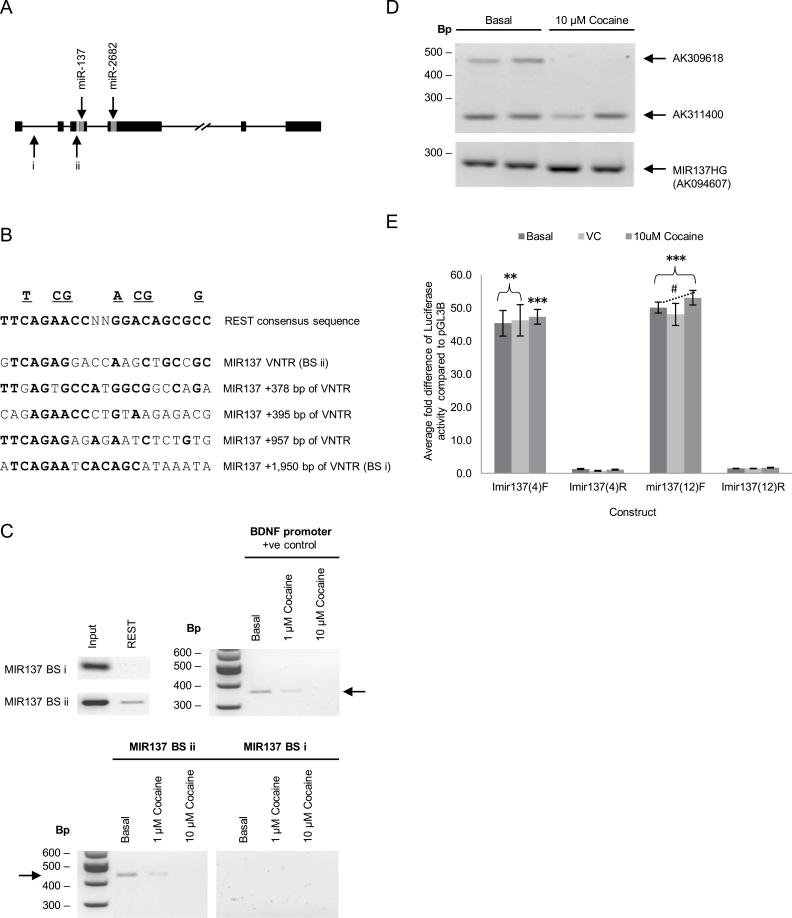
REST modulation of the MIR137 internal promoter in SH-SY5Y cells. (A) Predicted REST binding sites (BS) across MIR137 identified using Transcription Factor ChIP-seq from ENCODE, UCSC Genome Browser (http://genome.ucsc.edu/). (B) Canonical 21bp binding motif found within REST target genes and sequence homology with predicted BS within MIR137. (C) Chromatin immunoprecipitation (ChIP) assays showing REST binding at the putative BSii encompassing the internal MIR137 promoter (Imir137) VNTR under basal conditions and after 1 hour treatment with 1 and 10 µM cocaine. (D) Expression profiling of mRNAs expressed from the MIR137 locus after 1 hour treatment with 10 µM cocaine. (E) Relative levels of luciferase expression supported by the Imir137(4/12)F/R constructs in response to 1 hour treatment with 10 µM cocaine. N = 4. *Significant changes in luciferase activity over backbone control levels. #Significant changes in luciferase activity between experimental conditions. */#
P < .05, **/##
P < .01, ***/###
P < .001.